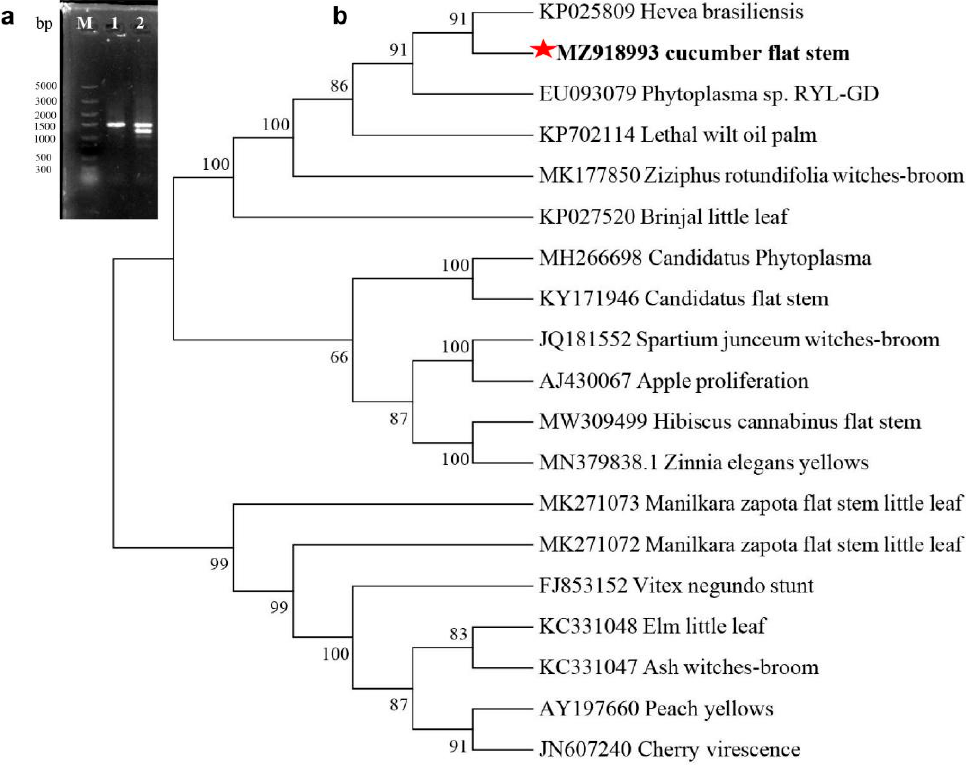
Figure 3. Detection and phylogenetic tree of 16S rRNA. ( a ) The amplification results of 16S rRNA by using nested PCR. M: Marker, lane 1 and 2 represents DNA extracted from the flat and healthy stems, respectively. ( b ) The phylogenetic tree of 16S rRNA gene sequences between the cucumber flat stem phytoplasma (the bold and red star) and several phytoplasma strains from GenBank. The bar indicates the phylogenetic distance based on the neighbor-joining method.